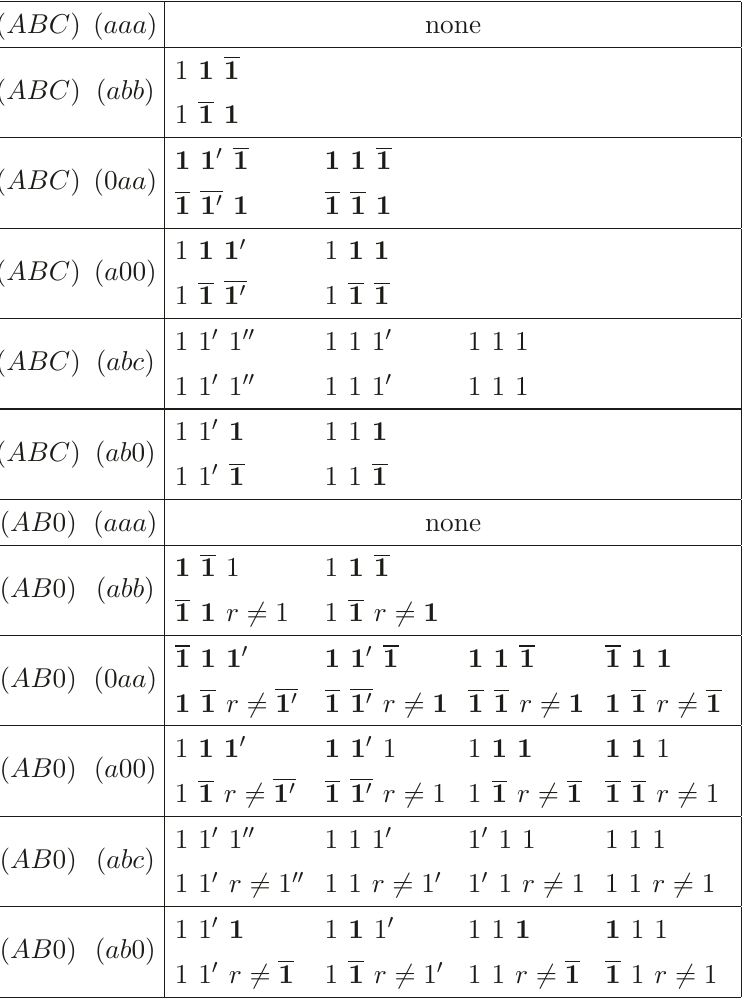
Table 3 . Possible decompositions of U l (above) and U e c (below) into irreducible components (part II). Each line corresponds to a combination of the charged lepton and neutrino mass patterns in the first two lines of table 1. The charged lepton patterns ( ABC ) and ( AB 0) are considered here, which require hierarchies among the non-zero entries. Irreps are denoted by their dimensions. Boldface fonts denote complex representations, regular fonts denote real representations. Primes are used to distinguish inequivalent representations, and in the case of complex representations 1 ′ is supposed to be different from both 1 and 1 . “ r ” denotes a generic, possibly reducible representation, different from or not including the specified irreps, as